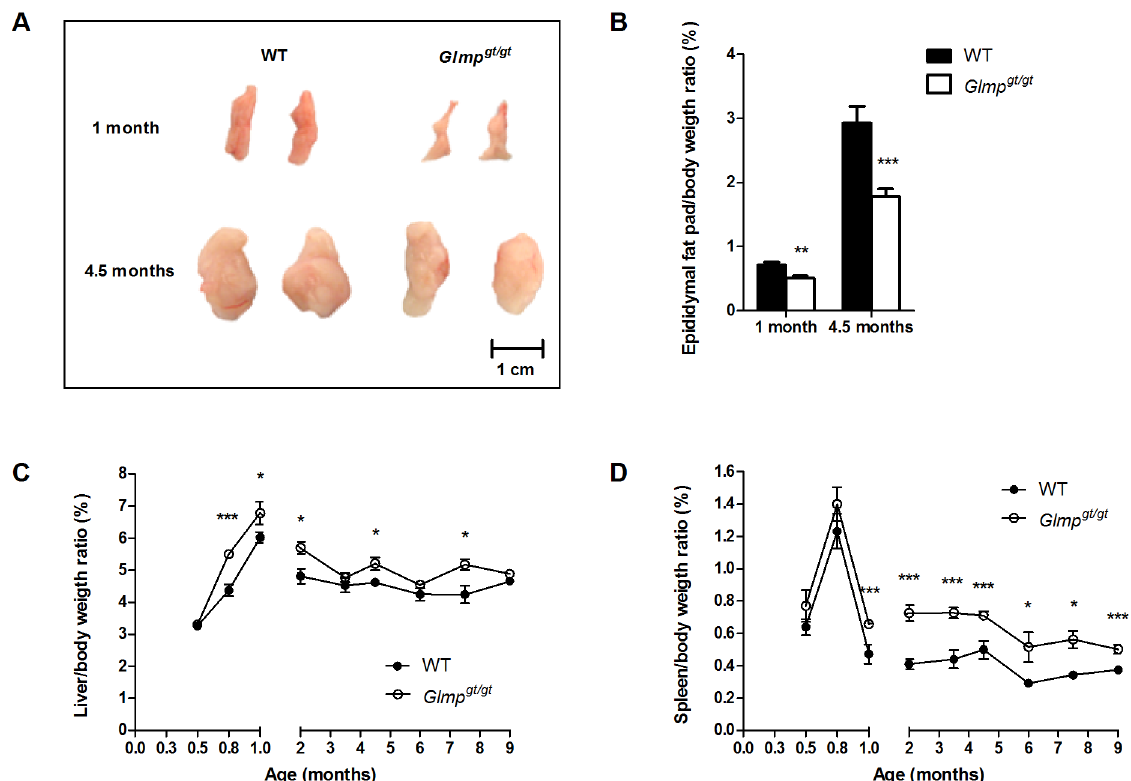
Fig 2. GLMP ablation causes reduced size of epididymal fat pads and hepatosplenomegaly. (A) Representative pictures of epididymal fat pads and (B) epididymal fat pads/body weight ratios in 1 (n = 4) and 4.5 months (n = 10 – 12) old WT and Glmp gt/gt mice. (C) Spleen/body weight ratios and (D) liver/body weight ratios in WT and Glmp gt/gt mice were examined at designated time-points between 2 weeks and 9 months of age (n = 10 – 12) ( * p < 0 . 05 , ** p < 0 . 01 , *** p < 0 . 005 vs. WT). Values are presented as mean ± SEM.